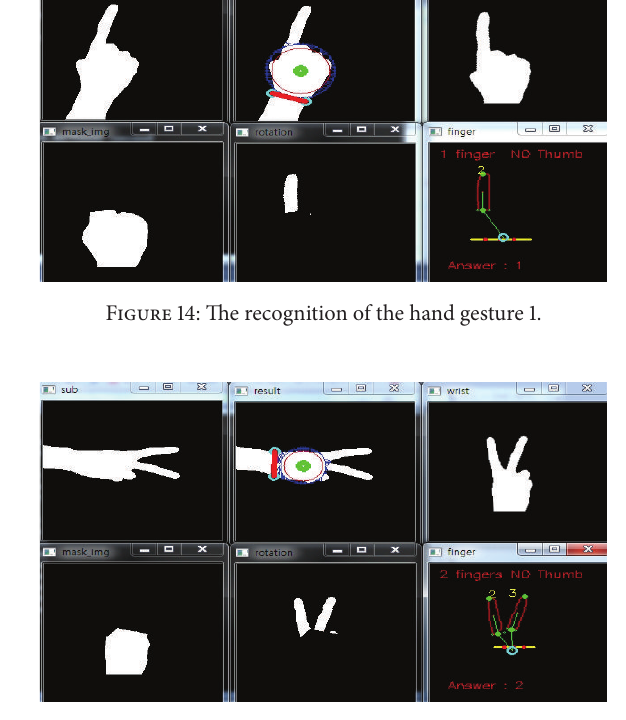
Figure 15: The recognition of the hand gesture